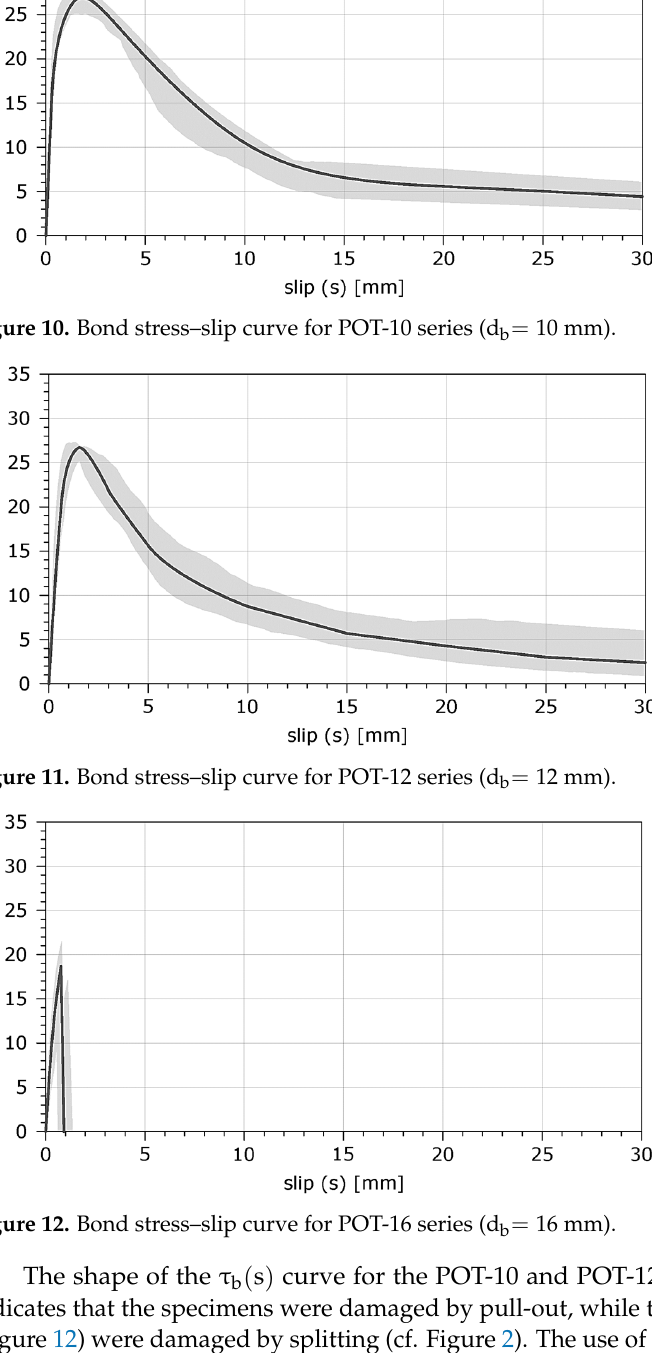
Figure 12. Bond stress–slip curve for POT-16 series (d b = 16 mm).